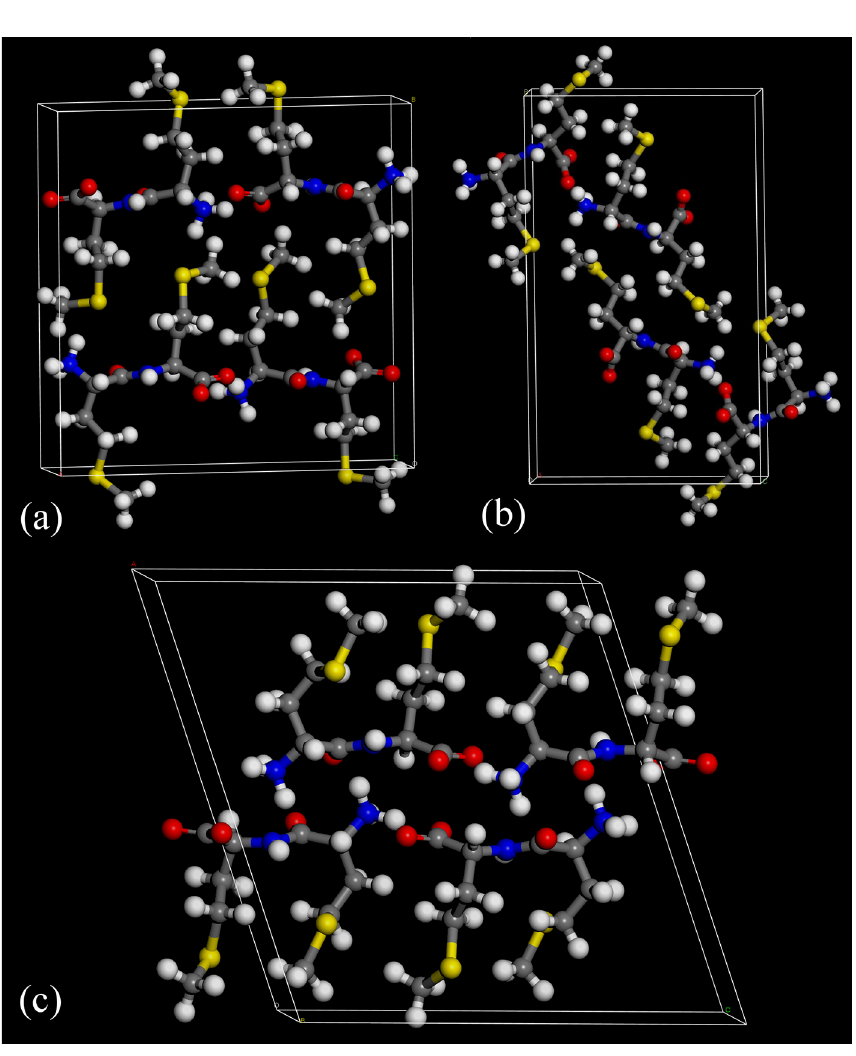
Figure 4. Crystal structures of: ( a ) ll, ( b ) dd–ll and ( c ) dl–ld. (Key: grey = C, white = H, red = O, blue = N, yellow = S). ORTEP plots of the asymmetric units of the novel dd–ll and dl–ld structures reported here are shown in Supplementary Figures S8 and